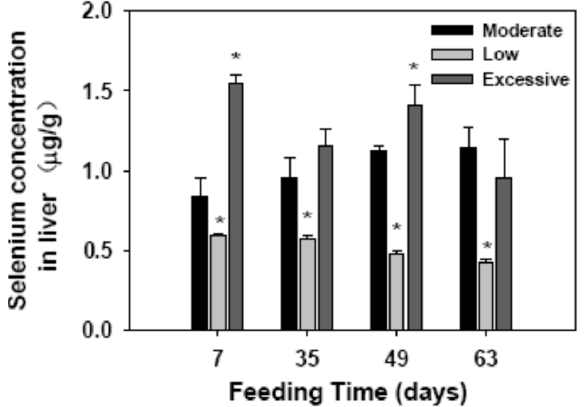
Figure 1. Selenium accumulation in the livers of mice fed different amounts of dietary selenium. Mice were fed low, excessive, or moderate (control) selenium diets, respectively. The liver selenium concentration was determined on the indicated day of consecutive feeding. Data were calculated from five mice in each group. * p < 0.05 compared with the control.